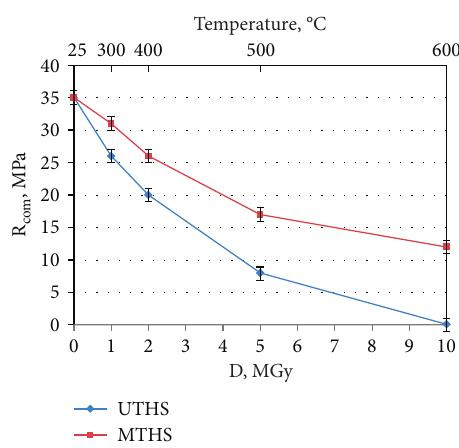
Figure 10: Strength of titanium hydride composites subjected to c